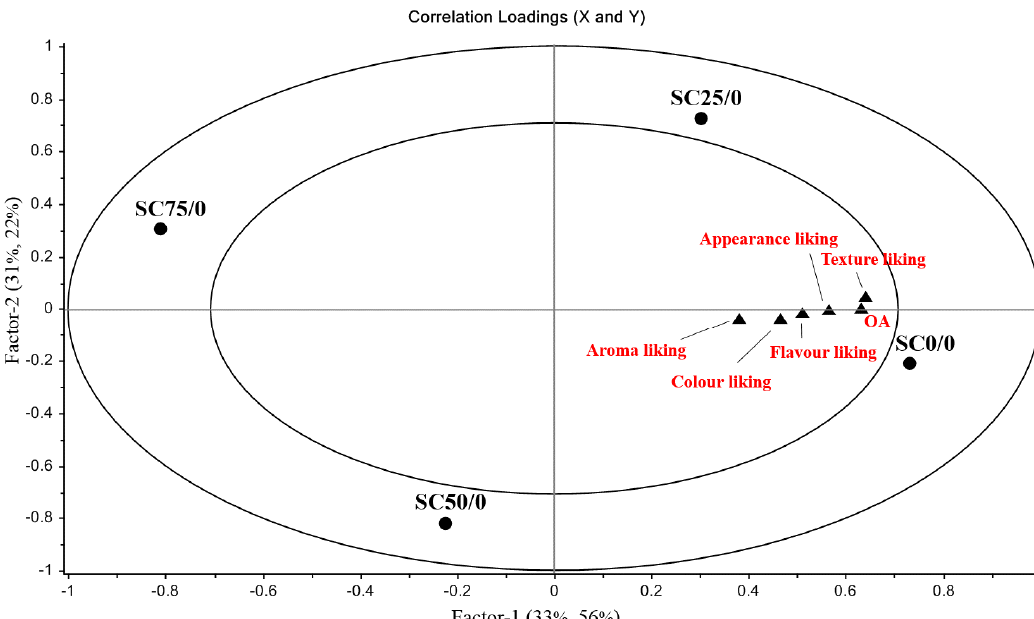
Figure 3. Partial least squares regression (PLSR) plot for the relationship between sponge cake samples with increasing levels of sucrose replacement: 0, 25, 50 and 75%, and hedonic sensory variables.